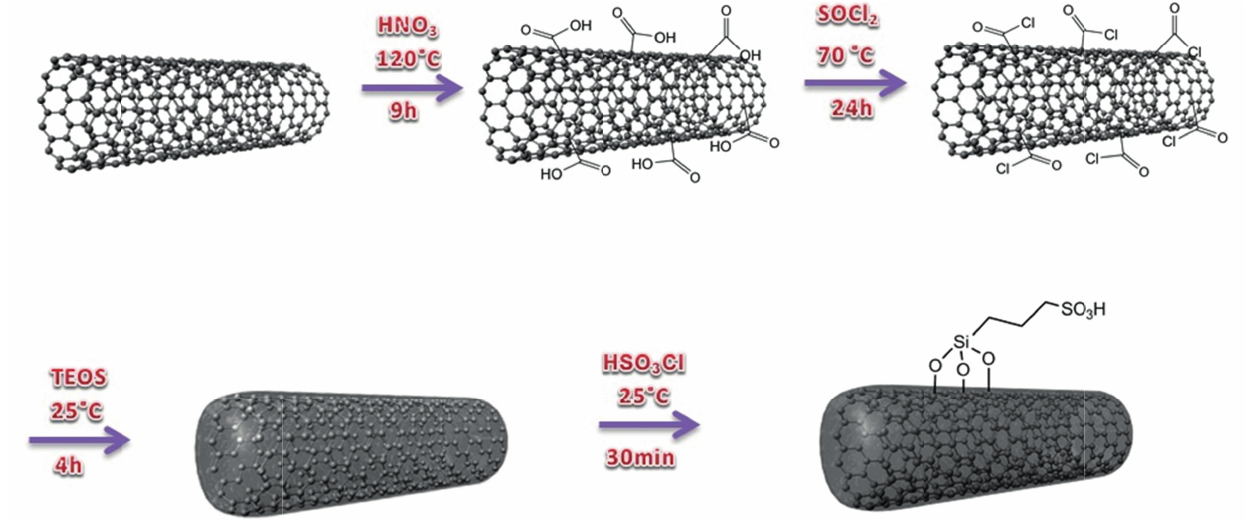
Fig. 1 . Schematic of the CNTs functionalization